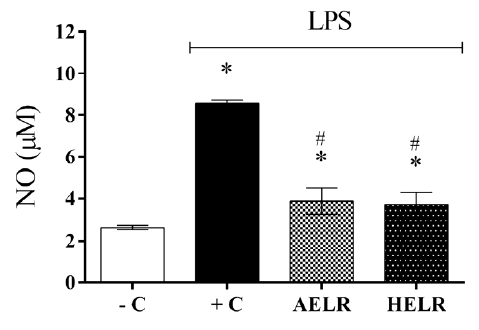
Figure 8. Inhibitory effects of L rigida extracts on LPS-stimulated nitric oxide (NO) production in RAW 264.7 macrophages: ( A ) AELR and ( B ) HELR. The NO level in the culture medium was quantified using Griess reagent. Data represent the mean ± SEM from three independent experiments. One-way ANOVA was used followed by a post hoc Tukey test. * p < 0.05 vs. the negative control group; # p < 0.05 vs. the LPS-stimulated cells. Figure 9. LPS-stimulated nitric oxide production in C57BL/6 mice. AELR ( L. rigida aqueous leaf extract). HELR ( L. rigida hydroethanolic leaf extract). –C (negative control: animals not LPS-induced). +C (positive control: animals induced with LPS and treated with PBS). Results represent the means of NO ( µ M) levels, as well as standard deviations between animals in each group. Symbols indicate a statistical difference ( p < 0.05) by ANOVA, with Tukey post-test in the comparison between compounds. * p < 0.05 vs. the negative control group; # p < 0.05 vs. the LPS-stimulated group. n = 6.